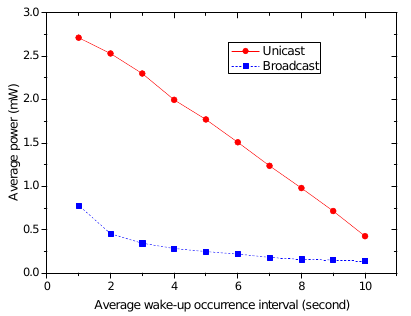
Figure 16. The energy consumption comparison of two wake-up mechanisms.